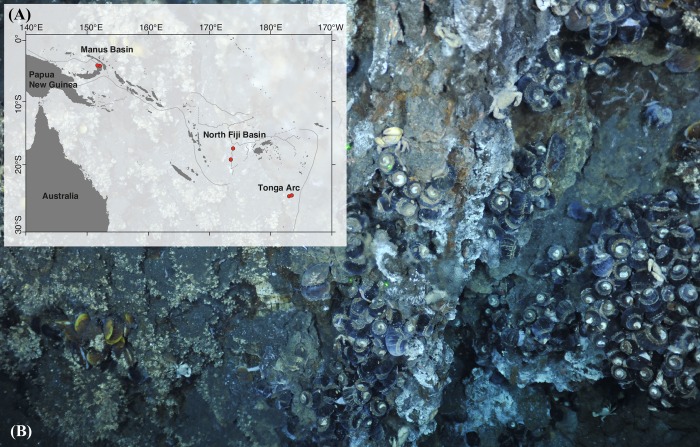
Map of A. alayseae sampling locations in the Southwest Pacific Ocean and a photograph of a hydrothermal vent in the North Fiji Basin and its associated biological communities.(A) Sampling locations of A. alayseae. Lines represent subduction zones. Red circles indicate sampling areas. Some sampling sites located short distances (<5 km) from each other (R1968-C6 and R1970-C3, R1964-C1 and 1966-C11, TA25A and TA25D) are marked with single circle. (B) An active vent at the 1970-C3 sampling site in the North Fiji Basin. The dominant visible taxa in the image are the provannid snail Ifremeria nautilei (center bottom and right) and the balanomorph barnacle Eochionelasmus ohtai (left). A small cluster of mytilid mussels, Bathymodiolus sp., and alvinocaridid shrimp species are visible. Scattered individuals of the bythograeid crab A. alayseae are generally seen in association with I. nautilei and E. ohtai.